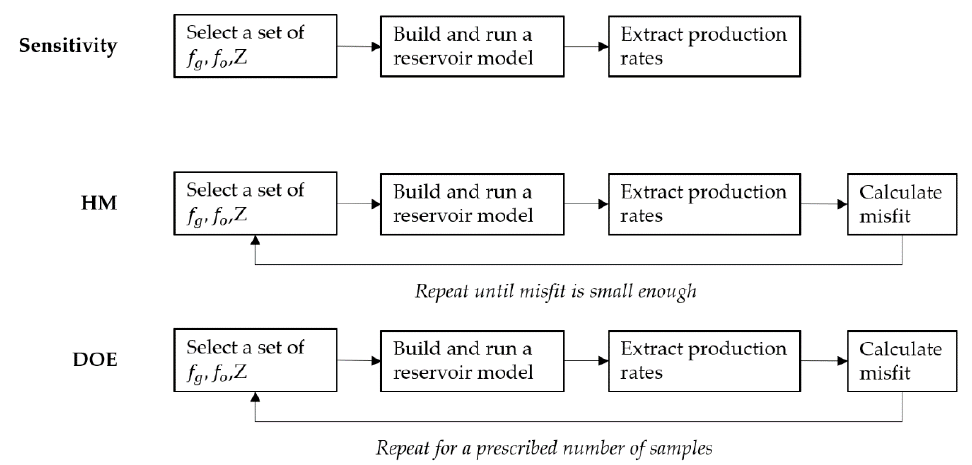
Figure 2. The reservoir simulation workflows, used in the present work: sensitivity study in Section 5, automatic history matching (HM) in Section 6, design-of-experiments (DOE) in Section 7. The simulations are run on a Lenovo ThinkStation workstation with 2 × Intel Xeon Silver 4210 processors (10 cores each) and total usable 126 GB RAM. One iteration for the full field upscaled reservoir model with 1.9 million active cells runs in approx. 1 h.